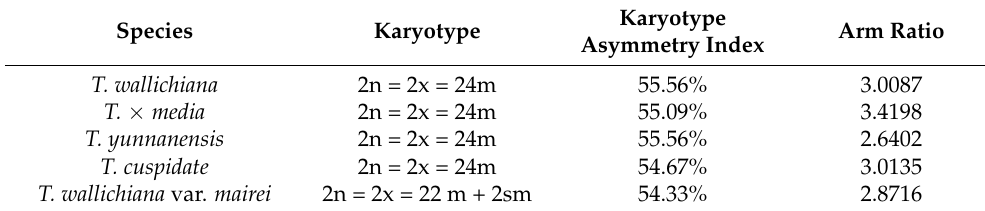
Table 2. Karyotype formulas of five species of Taxus